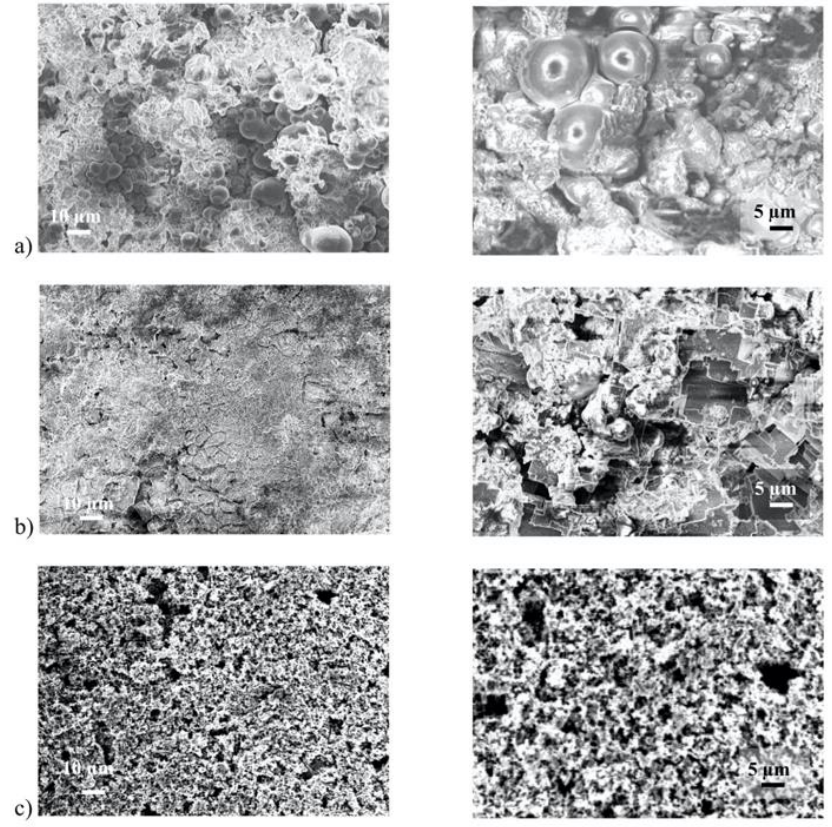
Figure 3. SEM images of textured aluminum: ( a ) Sample #1 after immersion in AlCl 3 , ( b ) sample #2 after immersion in FeCl 3 , and ( c ) sample #3 after immersion in CuCl 2 after the FOTS deposition. Reproduced with permission from